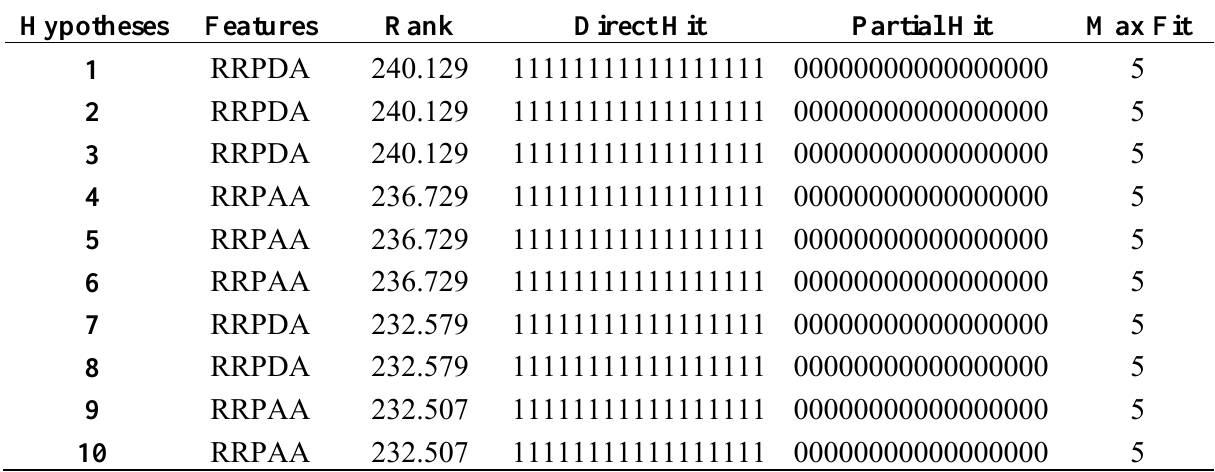
Table 1. The results of the top 10 hypotheses for β the HipHop program.